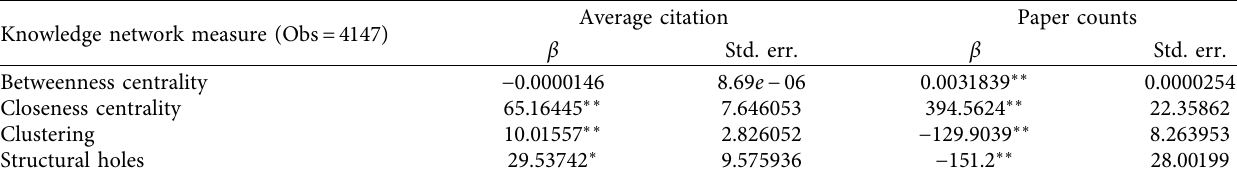
Table 4: Multiple regression